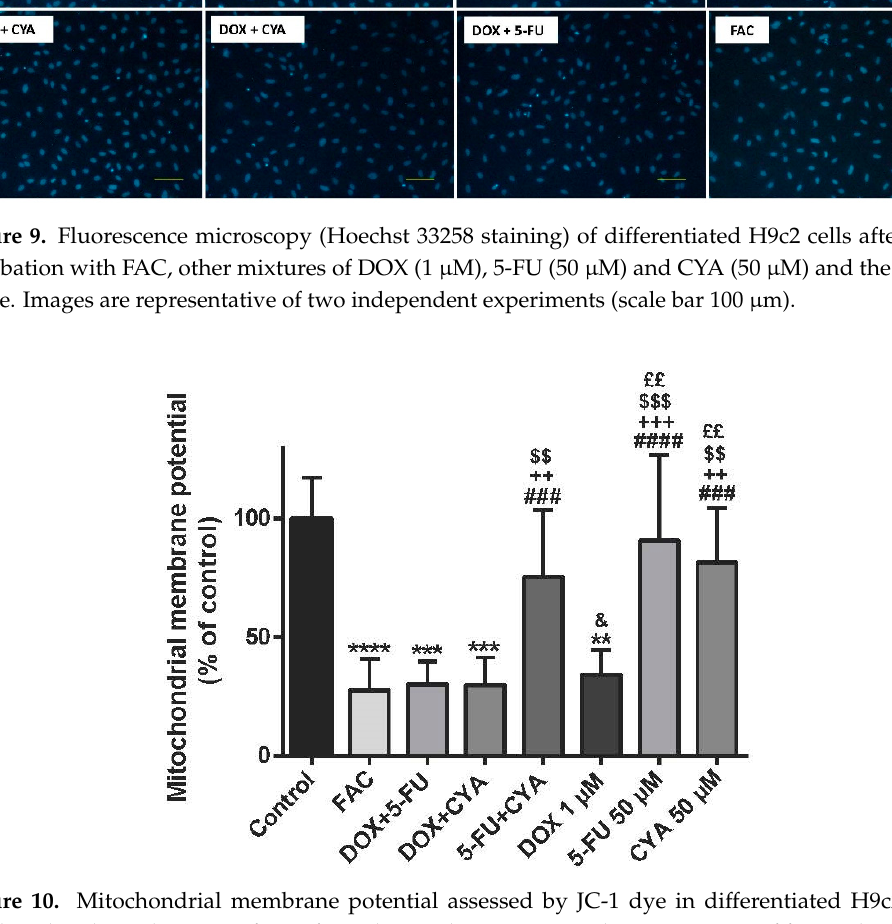
Figure 10. Mitochondrial membrane potential assessed by JC-1 dye in differentiated H9c2 cells incubated with combination of FAC for 48 h. Results are presented as mean ± SD of four independent experiments (total of 12 wells). Statistical analyses were performed using the Kruskal–Wallis test, followed by the Dunn’s post hoc test (** p < 0.01, *** p < 0.001, **** p < 0.0001 vs. control; ### p < 0.001, #### p < 0.0001 vs. FAC; ++ p < 0.01, +++ p < 0.001 vs. DOX + 5-FU; $$ p < 0.01, $$$ p < 0.001 vs. DOX + CYA; & p < 0.05 vs. 5-FU + CYA; ££ p < 0.01 vs. DOX).